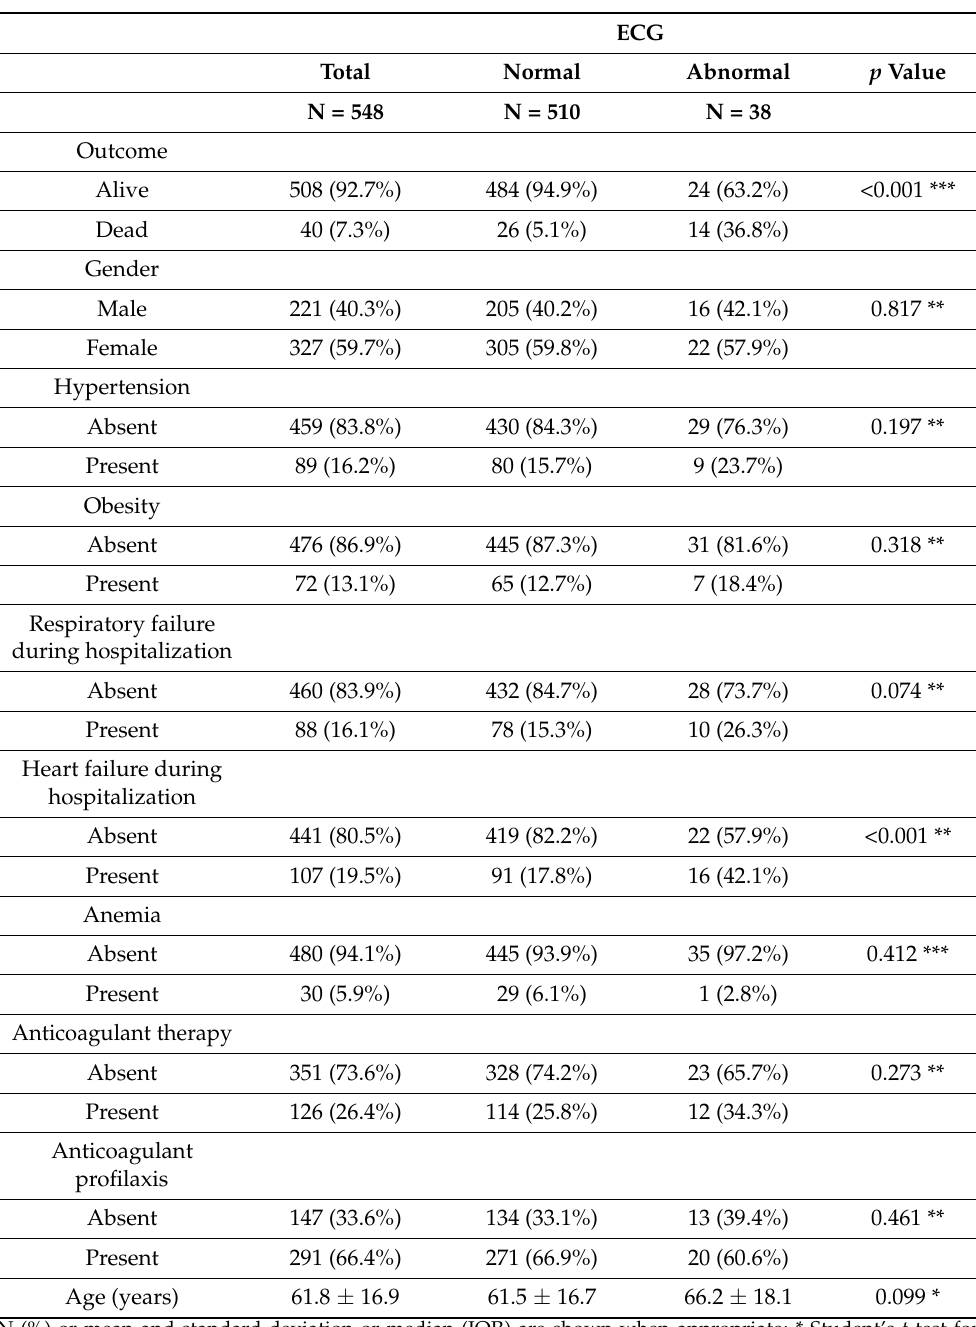
Table 1. Patient characteristics and comparison between patients with ECG normal and ECG abnor- mal ( n =